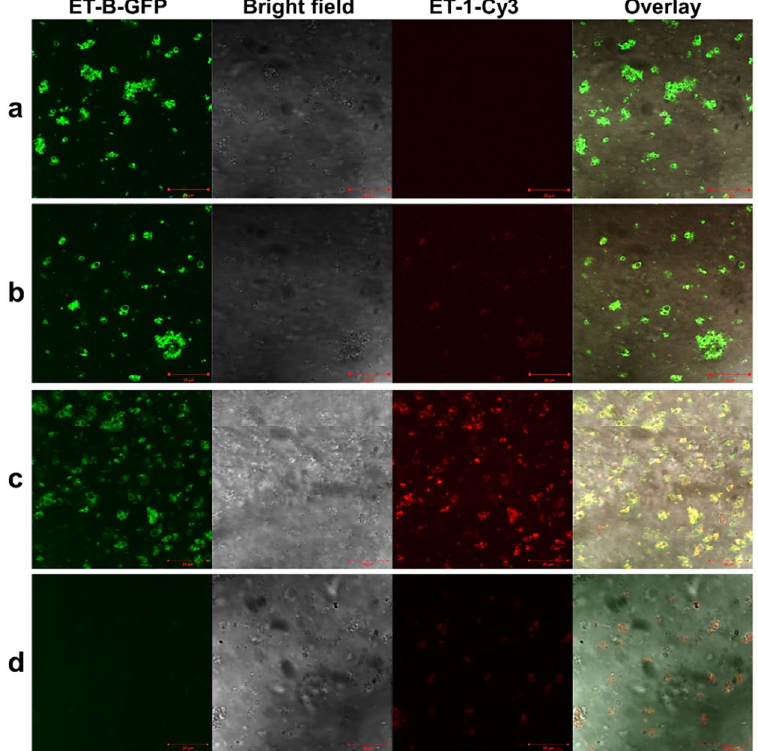
Figure 4. Determination of ligand binding using confocal laser scanning microscopy. ( a ) Confocal imaging of ET-B-GFP in absence of any ligands; ( b ) imaging of ET-B-GFP and ET-1-Cy3 in absence of any detergents; ( c ) Co-localization of ET-B-GFP and Cy3-ET-1 in the presence of 0.03% Brij35; ( d ) imaging of negative control and Cy3-ET-1 in the presence of 0.03%